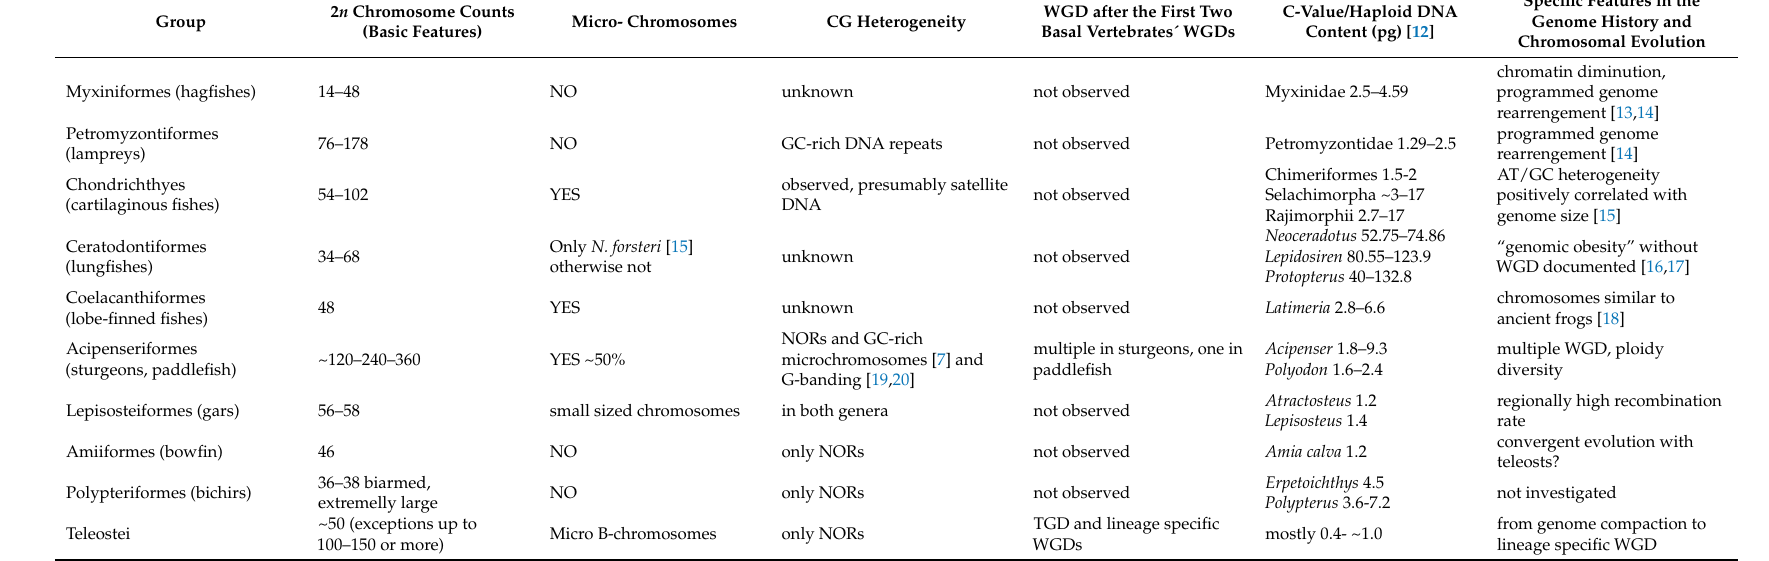
Table 1. Main cytogenomic traits in fish-like